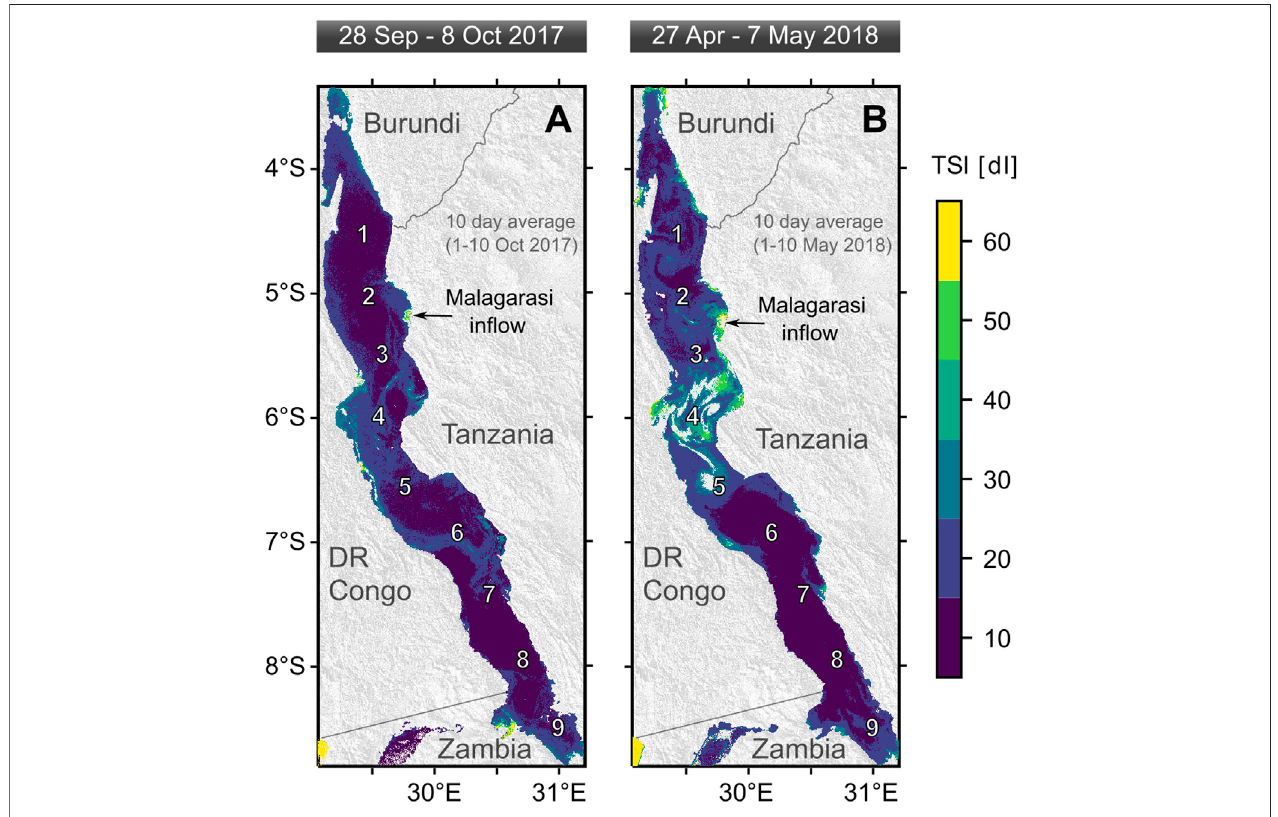
FIGURE 4 | Trophic State Index (TSI) products based on Sentinel satellite data illustrating elevated surface chlorophyll- a concentrations corresponding to fi lamentous cyanobacteria in the northern and central part of Lake Tanganyika during the expeditions (A) in September/October 2017 and (B) April/May 2018.